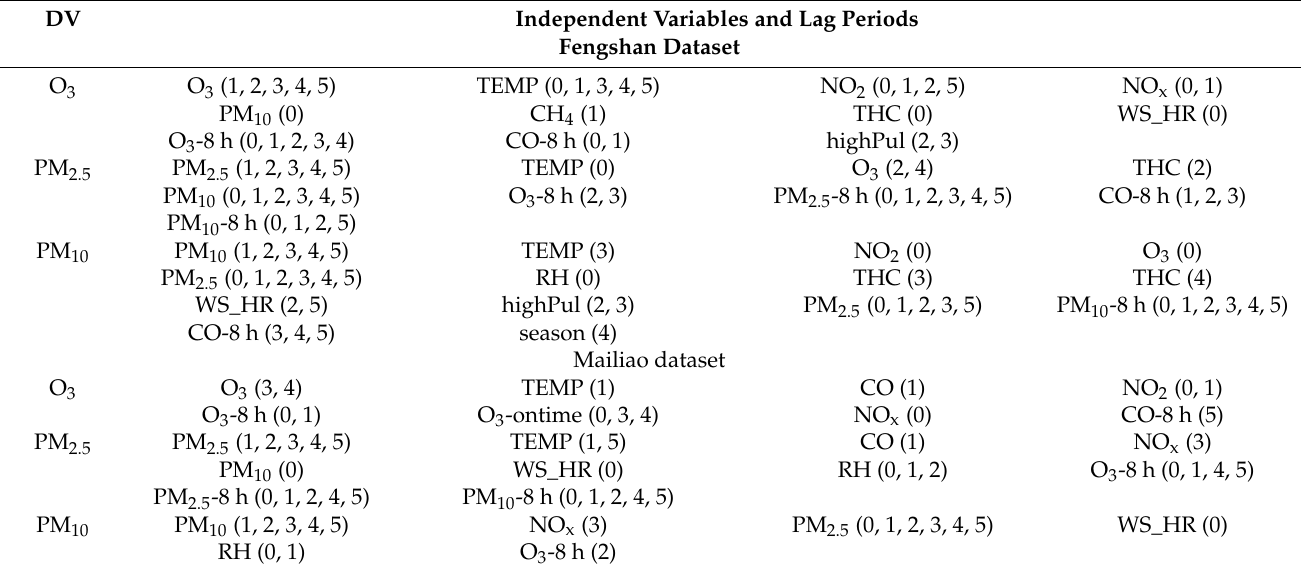
Table 7. Results of ARDL test for variable lag periods of two datasets.